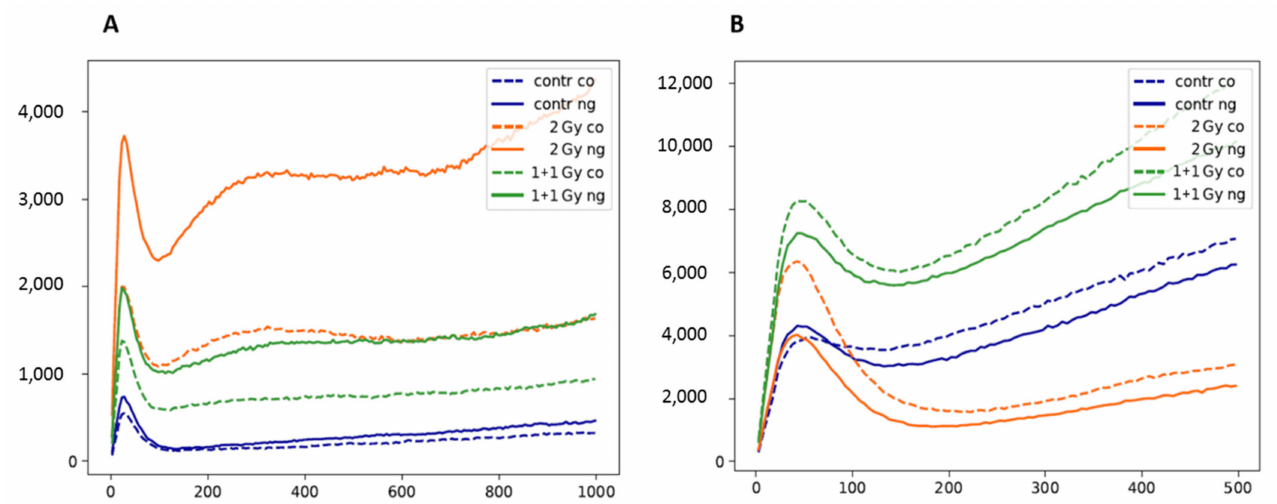
Figure 11. Ripley’s distance frequency analysis at 0.5 h post-irradiation. The absolute frequencies of pairwise distances ( ordinate ) vs. the distances in nm ( abscissa ) are presented for the different types of experiments; contr = non-irradiated control; 1 + 1 Gy = radiation scheme 1 Gy—30 min—1 Gy; ng = GNPs (nano-gold); co = control without GNPs. ( A ) Pairwise distance numbers of γ -H2AX labeling signals. ( B ) Pairwise distance numbers of H3K9me3 labeling